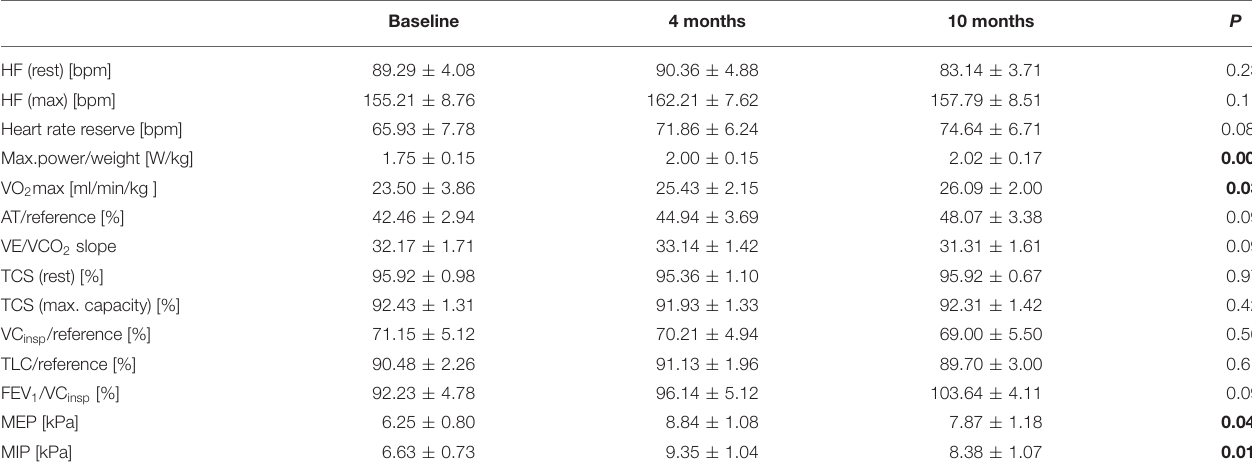
TABLE 4 | Cardiopulmonary exercise testing (CPET, teenage/adult subgroup, n = 14). Baseline 4 months 10